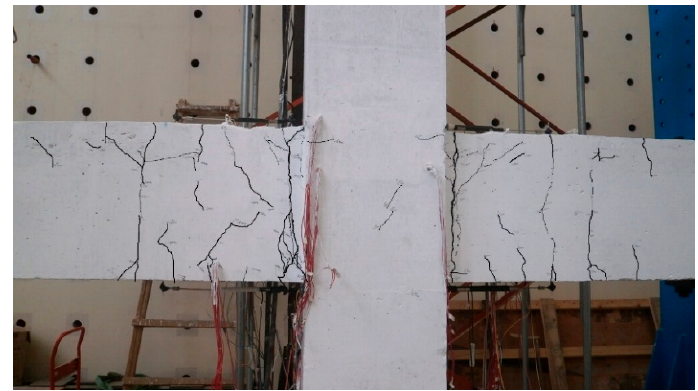
Figure 14. Distribution of cracks on the beam after yielding of the PPCJ2 joint.